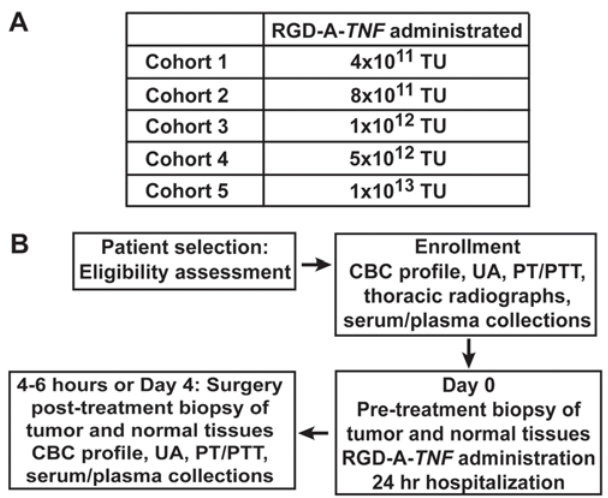
Figure 1. Schema representing the schedule for the dose escalation phase of RGD-A- TNF evaluation in dogs with spontaneous cancers. (A) This study was structured as a dose- escalation using a modified Fibonacci design to govern dose escalation towards an MTD. (B) Three dogs were enrolled in the starting-dose cohort, and three dogs per cohort were enrolled there after for each of the five dose levels planned. Dogs were scheduled to receive RGD-A- TNF on day zero and to undergo definitive tumor resection 4 days later. This initial 4-day group was designed (i) to evaluate vector localization and TNF a expression within tumors and (ii) to verify that the tentative follow-up schedule of RGD-A- TNF administration at one-week dosing intervals was biologically appropriate. After a group of dogs (n=18) were treated according to this schedule, an additional group was enrolled by equivalent inclusion criteria to receive RGD-A- TNF on the same day of definitive surgical resection. In this subset of dogs (n=6), surgery was performed 4–6 hours post administration of RGD-A-